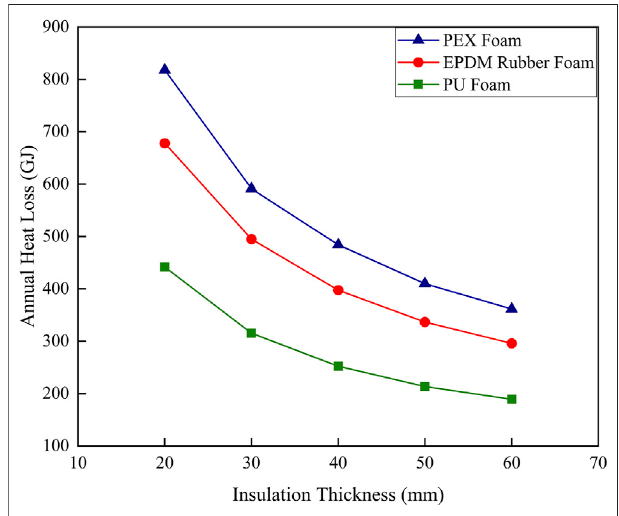
FIGURE 8 | Effect of Insulation thickness on total annual heat loss for different Insulation Materials.